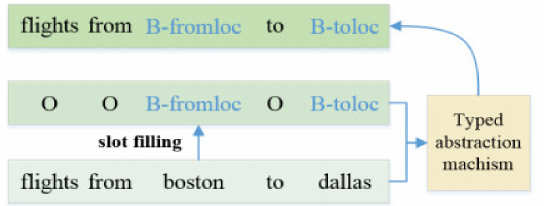
Figure 2. The implementation of a typed abstraction mechanism. It replaces slot words in the input text with abstract type words through the results of the SF